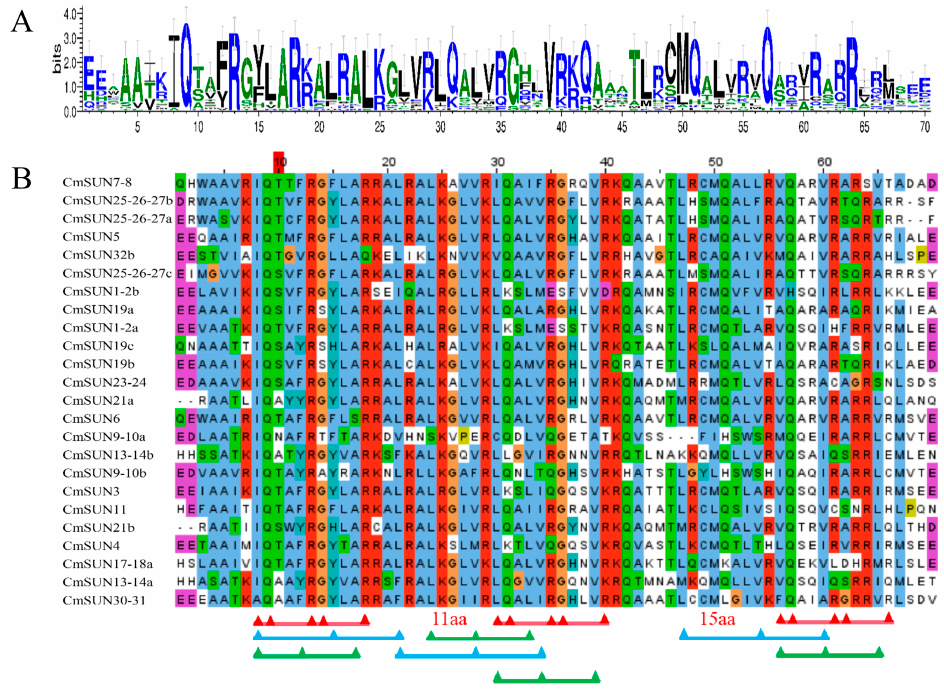
Figure 3. CmSUNs protein sequence analyses. ( A ) The logos show the conserved sites in IQ67 domain in CmSUN sequences. ( B ) Multiple sequence alignment of 24 CmSUN proteins. The red lines represent the ‘IQ’ core motif; The blue lines represent the ‘1-8-14’ motif; The green lines represent the ‘1-5-10’ motif; ‘11 aa’ and ‘15 aa’ represent the amino acid interval between the three ‘IQ’ motifs.